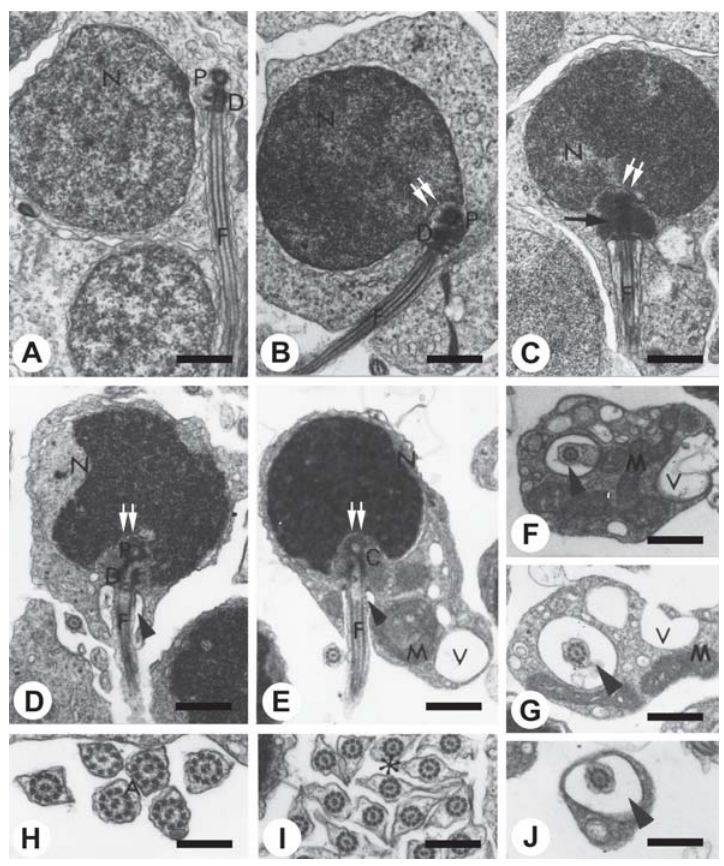
Fig. 1. Serrasalmus maculatus spermiogenesis. A to C - Longitudinal sections of early spermatids during the nuclear rotation process. D and E - Longitudinal sections of early spermatids during the chromatin condensation process. F, G and J - Midpiece cross sections. H and I - Flagella in cross sections. Scale bars: A to C = 1 µ m; D = 0.85 µ m; E = 0.9 µ m; F = 0.9 µ m; G = 0.75 µ m; H = 0.04 µ m; I = 0.75 µ m; J = 0.6 µ m. A: axoneme; C: centriole complex; D: distal centriole; F: flagellum; M: mitochondria; N: nucleus; P: proximal centriole; V: vesicle; Asterisk: fins; Arrow: electron dense material; Arrowhead: cytoplasmic canal; Double arrow: nuclear